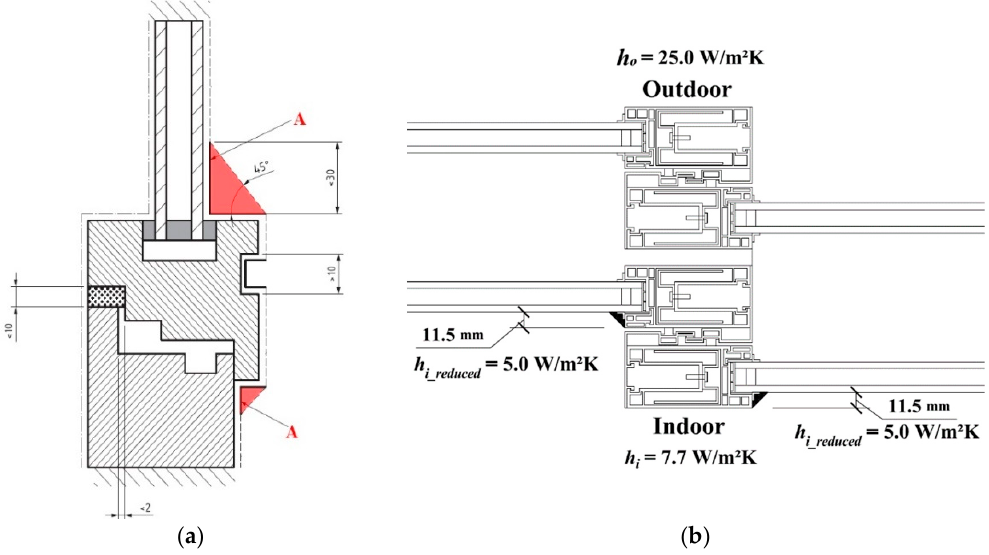
Figure 8. Surface heat transfer coefficients: ( a ) schematic example of the boundary treatment in ISO 10077-2 (A: area of reduced surface heat transfer); ( b ) boundary conditions for simulation.